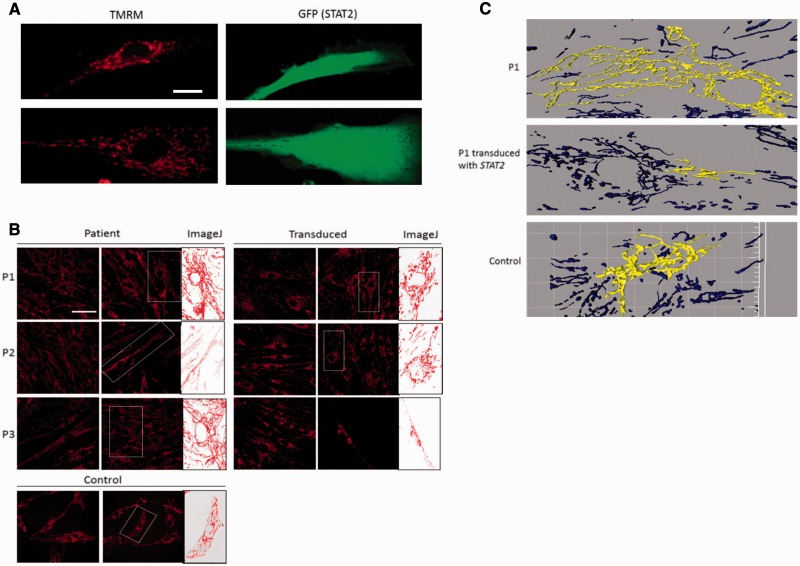

Image analysis of mitochondria in transduced patient and control fibroblasts. (A) Confirmation of lentiviral transduction in patient fibroblasts using GFP tag. Patient fibroblasts transduced with STAT2, stained with TMRM (left) and GFP expression upon reintroduction of STAT2 (right). Scale bar = 20 μm. (B) TMRM stained mitochondria in STAT2 transduced patient and control fibroblasts. Mito-Morphology Macro was installed on ImageJ, which measures mitochondrial interconnectivity and elongation from epifluorescence micrographs of cells stained for mitochondria. The perimeter length of the selected mitochondria is then measured using the software. Scale bar = 50 μm. (C) Three-dimensional representations of mitochondria in Patient 1 fibroblasts before (top) and after (middle) transduction with STAT2, and control fibroblasts (bottom). Confocal z-stack images of mitochondria stained with TMRM were reconstructed using IMARIS X64 software (version 7.6.3, Bitplane) to give 3D representations of the mitochondria present in each cell. Single connected mitochondria depicted as yellow.